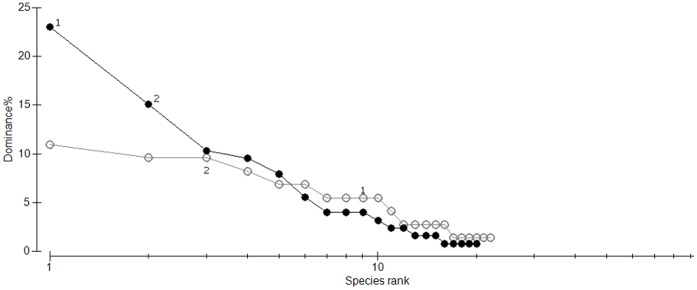
Rank abundance curve of independent visits to hollows in remnants (black line with closed circles) and continuous forest (grey line with open circles).‘1’ denotes the rainbow lorikeet. ‘2’ denotes the sulphur-crested cockatoo.